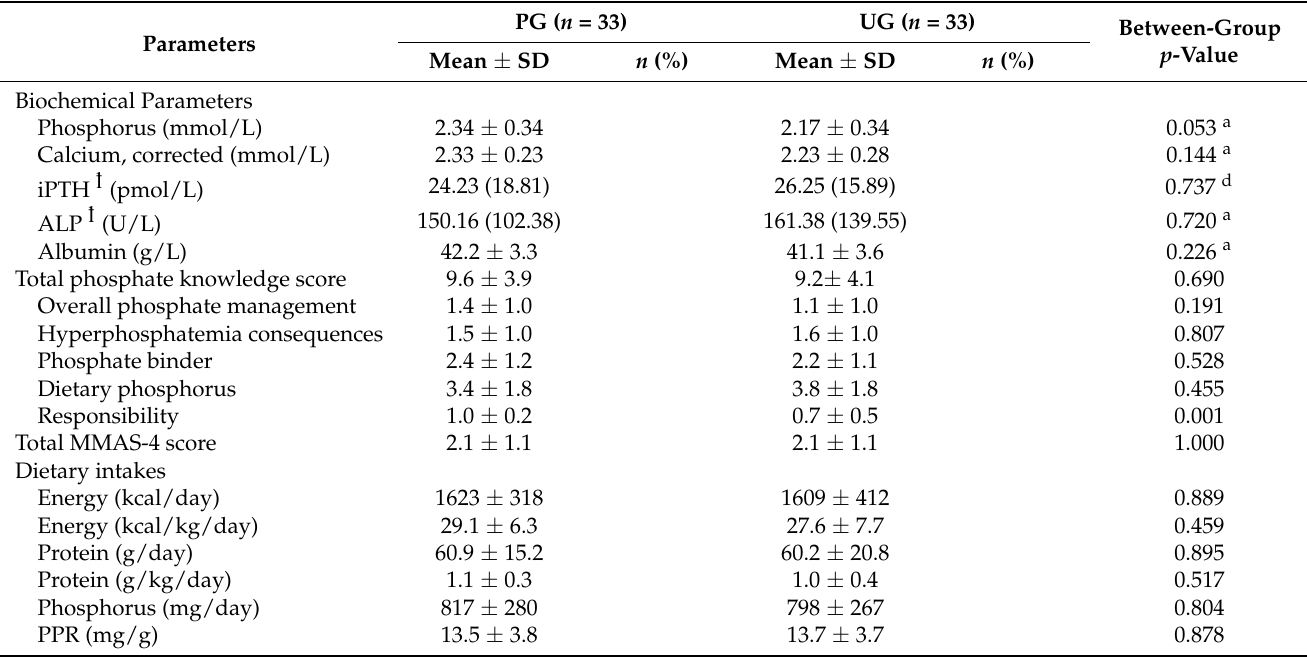
Values are expressed as median (interquartile range). a Independent-samples t-test, b Pearson’s chi-squared test, c Fisher’s exact test, d Mann–Whitney test. Abbreviation: BMI, body mass index; HD, hemodialysis; iPTH, intact parathyroid hormone; Kt/V, dialysis treatment adequacy index; OS, operating system; PG, PMA group; PPR, phosphorus-to-protein ratio; UG, usual care group. * Anemia = serum hemoglobin (Hb) level < 11